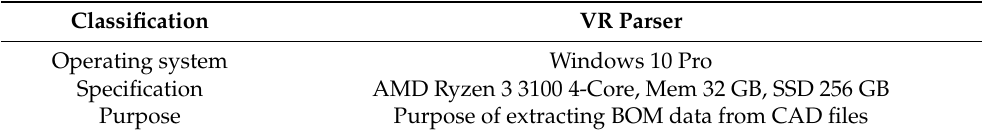
Table 2. VR Parser Classification.